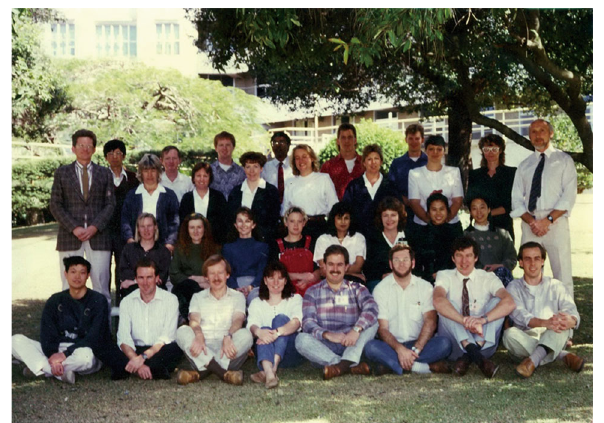
Figure 4. Dr. Jian Zhou (1st from left in the front row) at the Center for Cancer and Immunology Research of The University of Queensland.